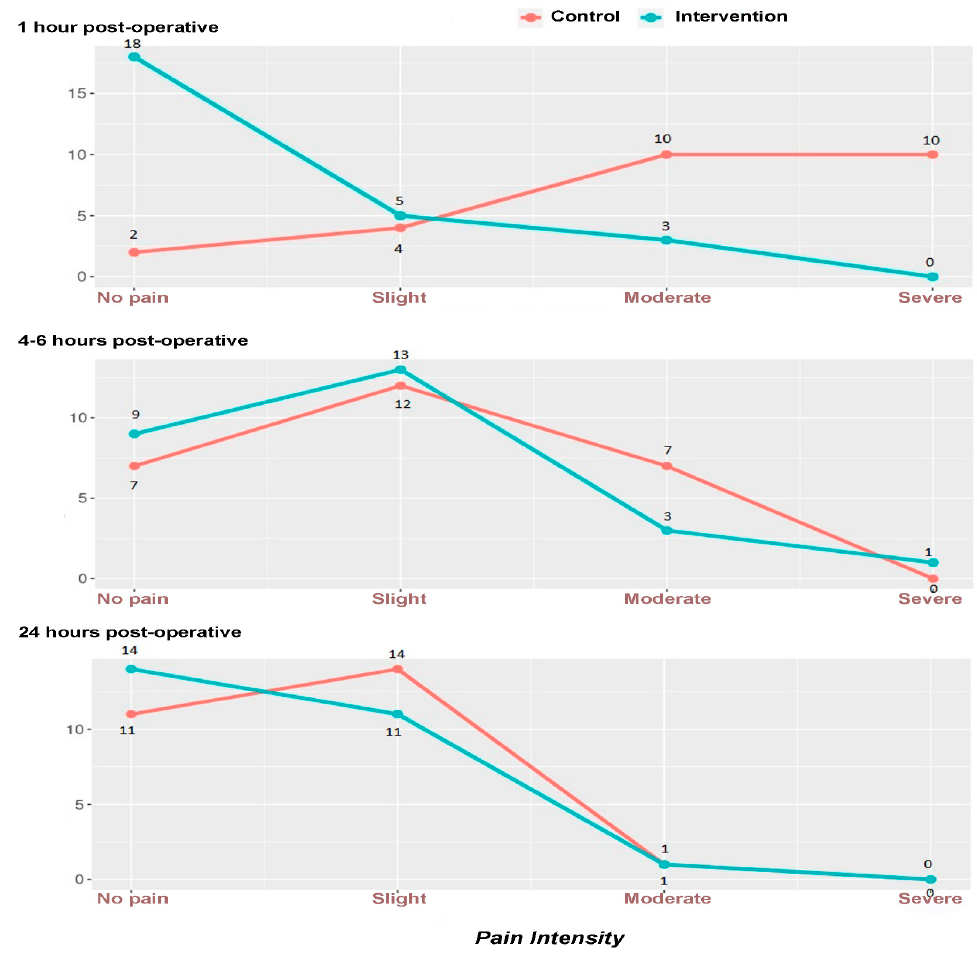
Figure 4. Graphs of the incidence of postoperative pain using the categories no pain, slight, moderate, and severe pain.